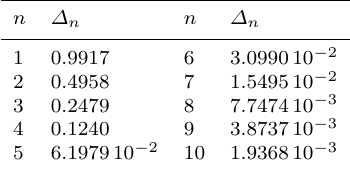
Table 2. Estimation ( ∆ n ) of the error resulting from relation